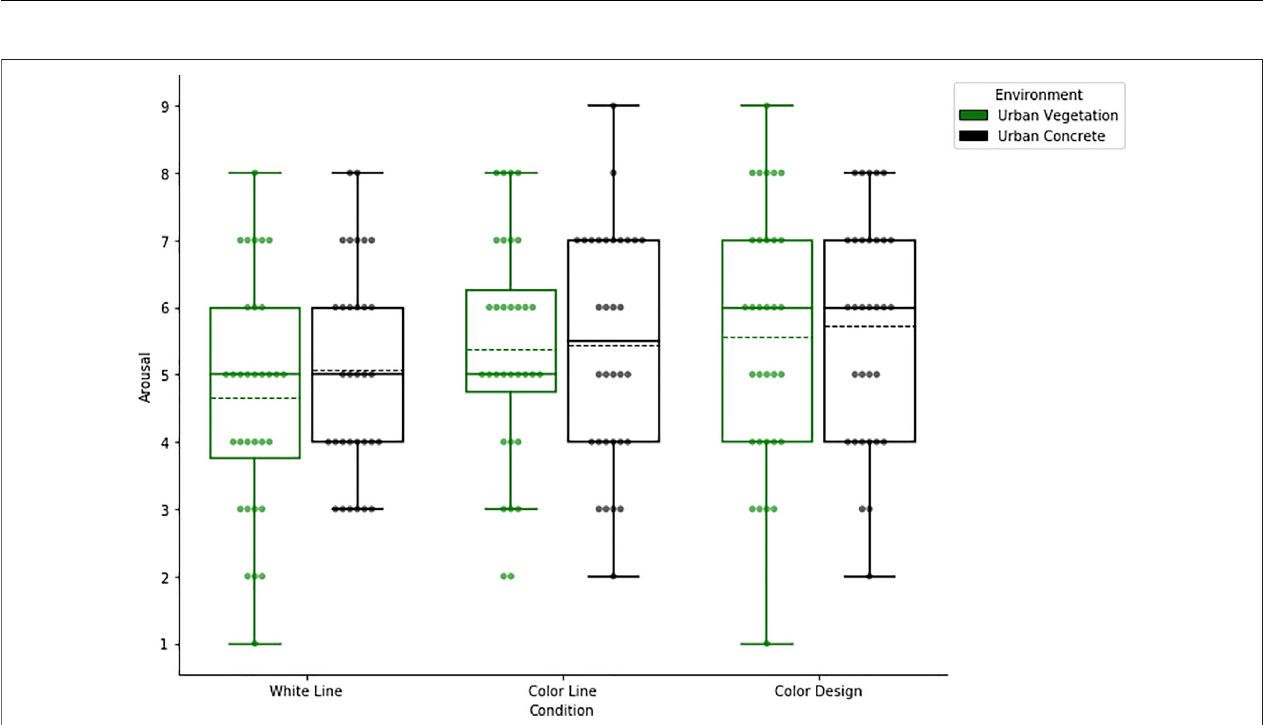
FIGURE 5 | Bar charts illustrating the impact of Environment (Concrete vs . Vegetation) and Condition (White Line; Color Line; Color Design) on the arousal dimension of the FAtAAL grid, which reports the perceived alertness experienced during spontaneous walking in the six different urban virtual environments.